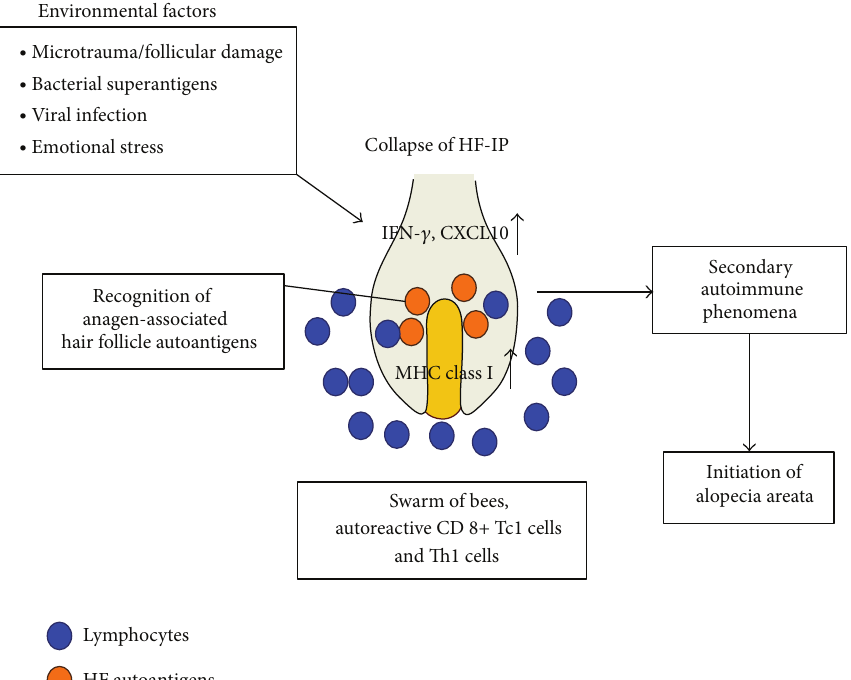
Figure 1: The pathogenesis of alopecia areata and treatment strategies. Environmental factors such as viral infections and bacterial superantigens may induce IFN- 𝛾 and CXCL10 expressions in the hair bulbs. Subsequently, autoreactive Th1 and Tc1 cells (blue circles) accumulate in and around hair bulbs—the so-called “swarm of bees.” Anagen-associated hair follicle (HF) autoantigens (orange circles) are recognized by Th1 and Tc1 cells, which lead to a secondary autoimmune phenomenon and resultant hair loss.